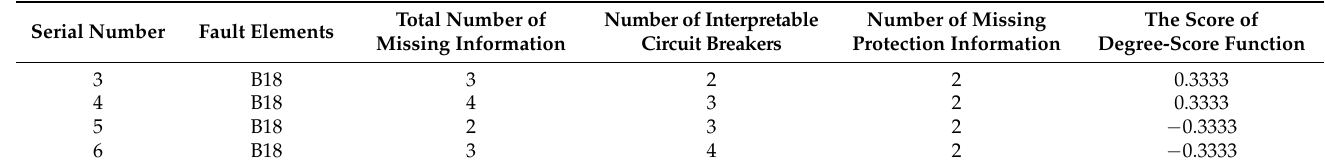
Table 4. The score of the B18 fault hypothesis.